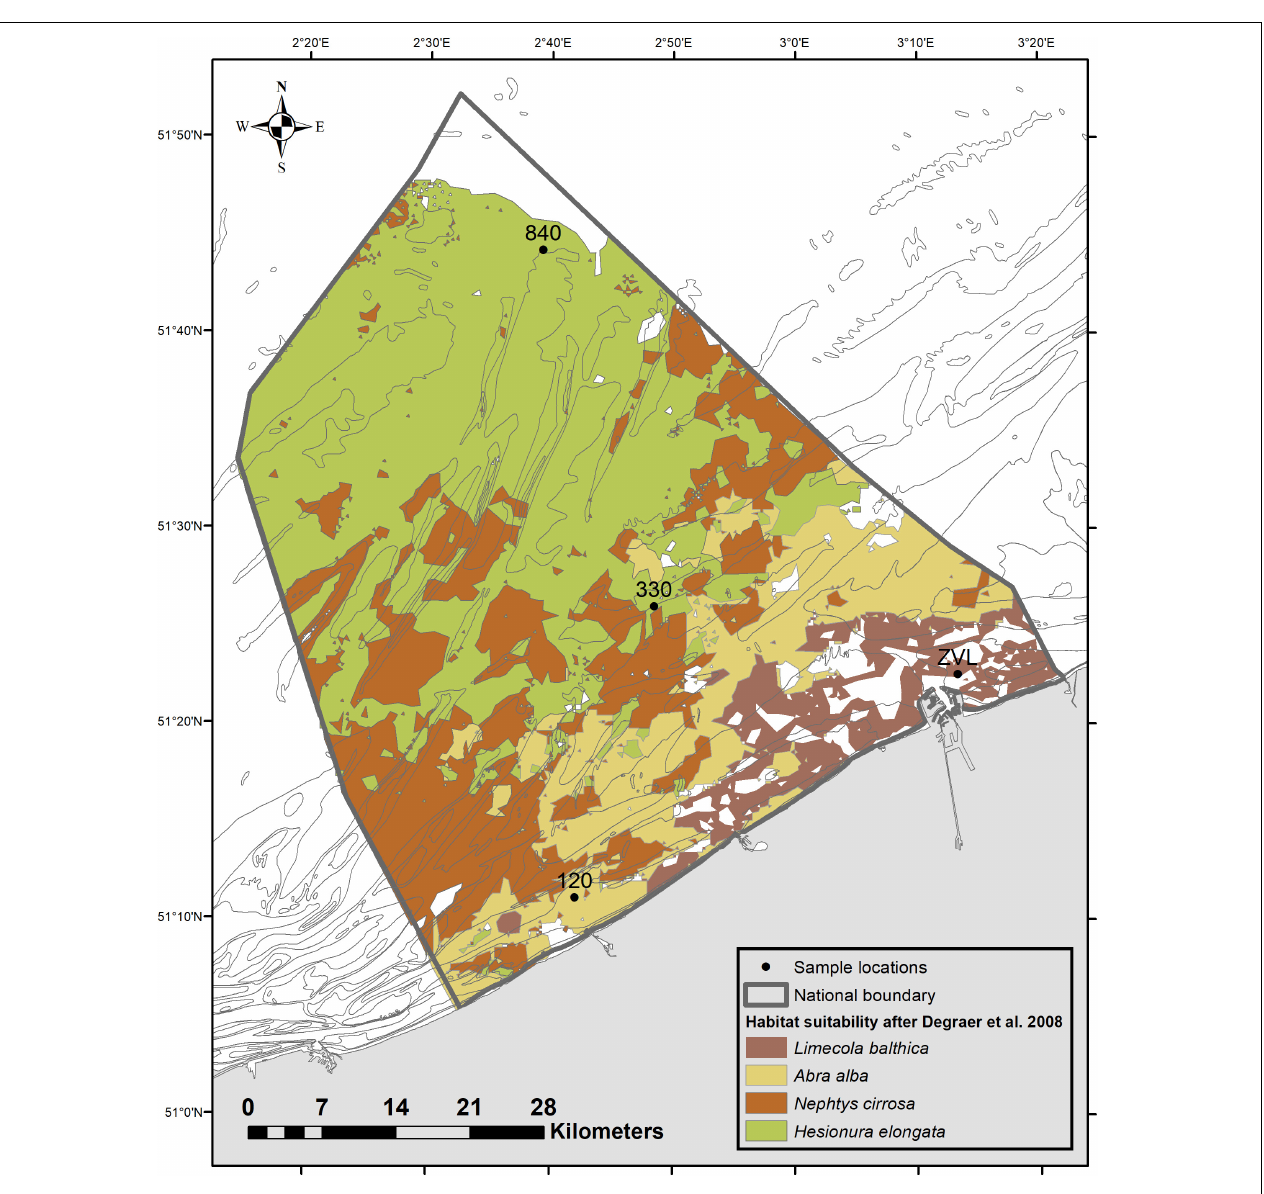
FIGURE 1 | Overview map with sampling locations for this study in the Belgian part of the North Sea. Location 120: coastal fine sandy habitat; Location 330: medium sandy habitat; Location ZVL: fine muddy habitat; Location 840: offshore coarse sandy habitat. Colors indicate the distribution of the macrobenthic communities, white areas are undefined (after Degraer et al.,